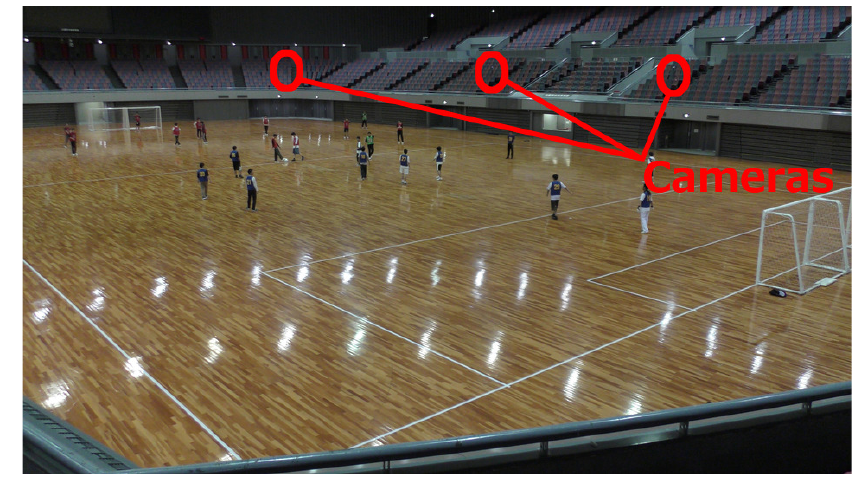
Figure 2. Example of captured image.